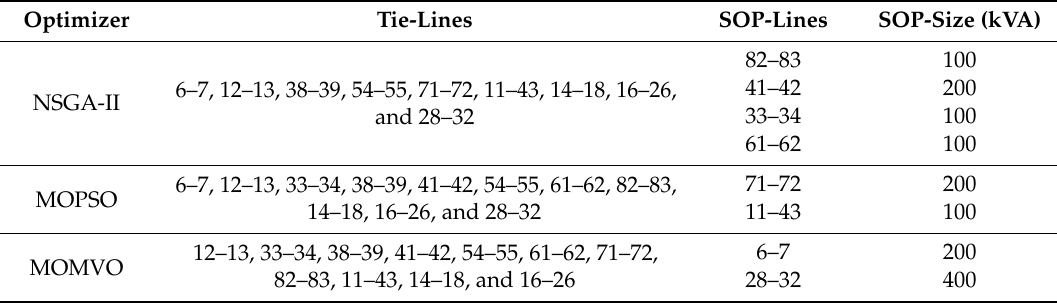
Table 6. Tie-lines, SOPs size, and locations.